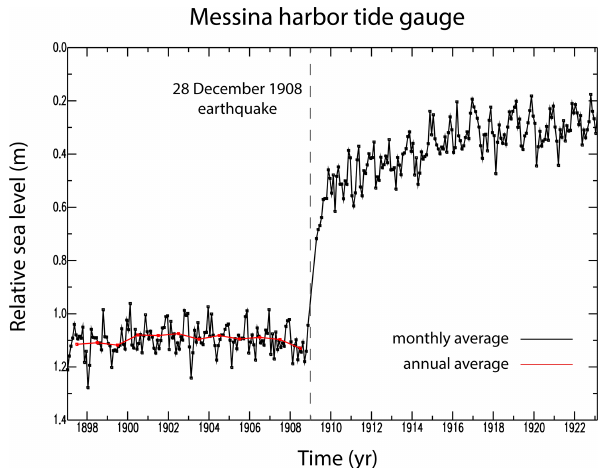
Figure 2. Monthly (black) and annual (only for 1897–1908; red) mean height of sea level recorded at the Messina harbor tide gauge. The positive direction of the vertical axis is downward, as was the case for the tide gauge, with the measures representing the height of sea level relative to the benchmark located in the gauge house, above sea